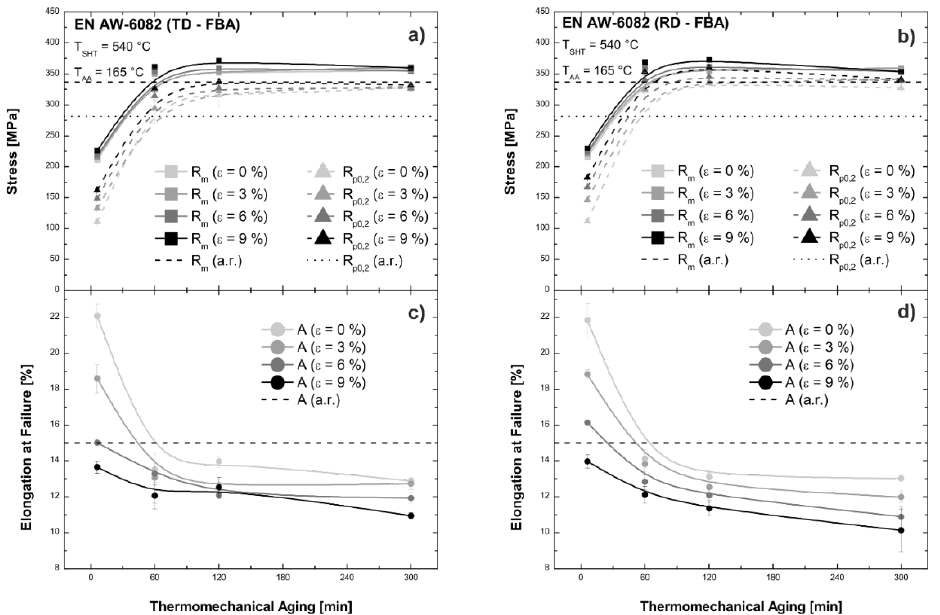
Figure 2. Influence of aging duration and strain on yield and ultimate tensile strength of AA6082 for thermo-mechanical aging strategy “ Forming before Aging ” ( a ) and ( c ) transverse and ( b ) and ( d ) parallel to the rolling direction. All specimens are taken from the thermo-mechanically aged conditions and are tested at room temperature.